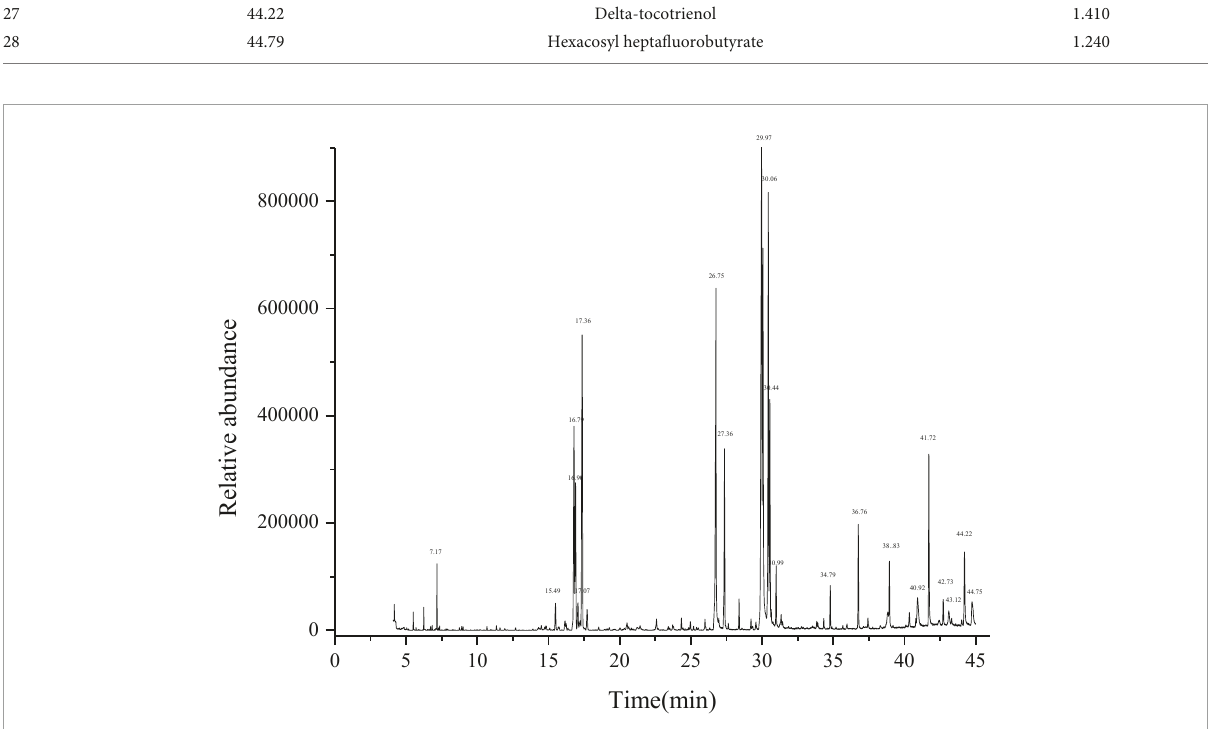
FIGURE1 Determination of total ion chromatogram of essential oil of litchi flower by gas chromatography-mass spectrometry equipment (GC-MS)